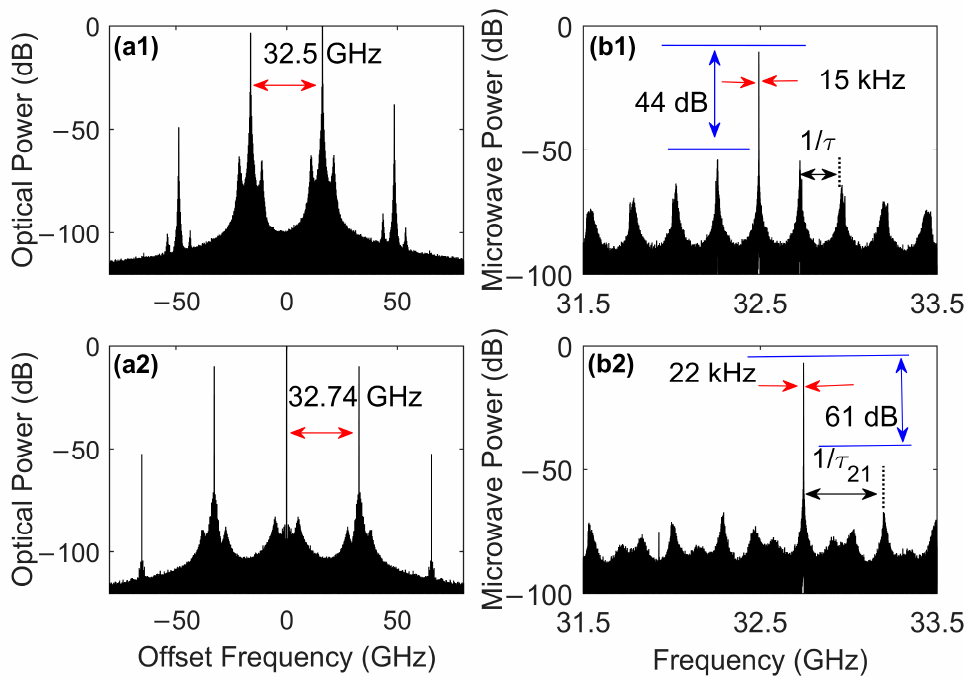
Figure 6. ( a1 , a2 ) Optical spectra and ( b1 , b2 ) RF spectra of the optically pumped QD spin-VCSEL subject to ( a1 , b1 ) single-loop feedback and ( a2 , b2 ) dual-loop feedback. The feedback strengths are fixed at k f = 2.5 ns − 1 and ( k f1 , k f2 ) = (1.5 ns − 1 , 1.5 ns − 1 ). The feedback delay times are set as τ = 4 ns and ( τ 1 , τ 2 ) = (4 ns, 6.5 ns ) in ( b ). Other parameters are the same as those in Figure 1 ( a1 , b1